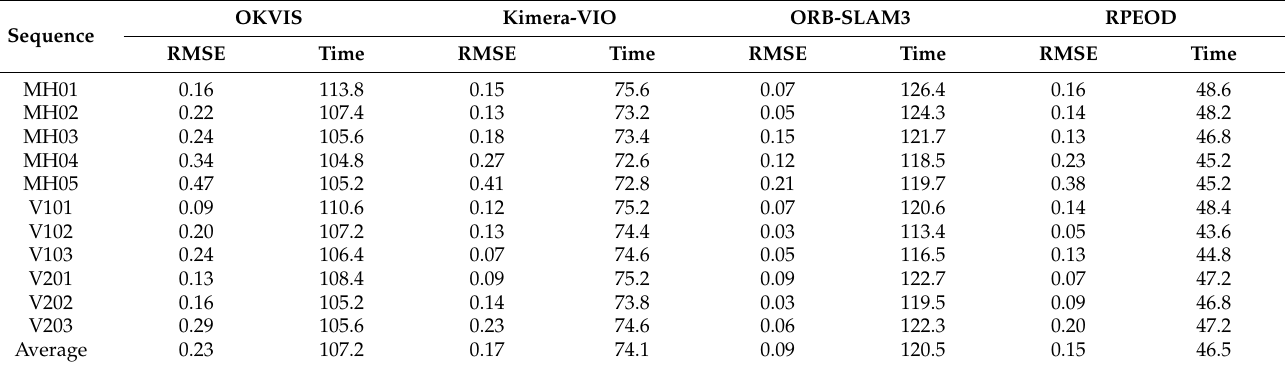
Table 2. Performance comparison in the EUROC dataset (Time in ms, RMSE in